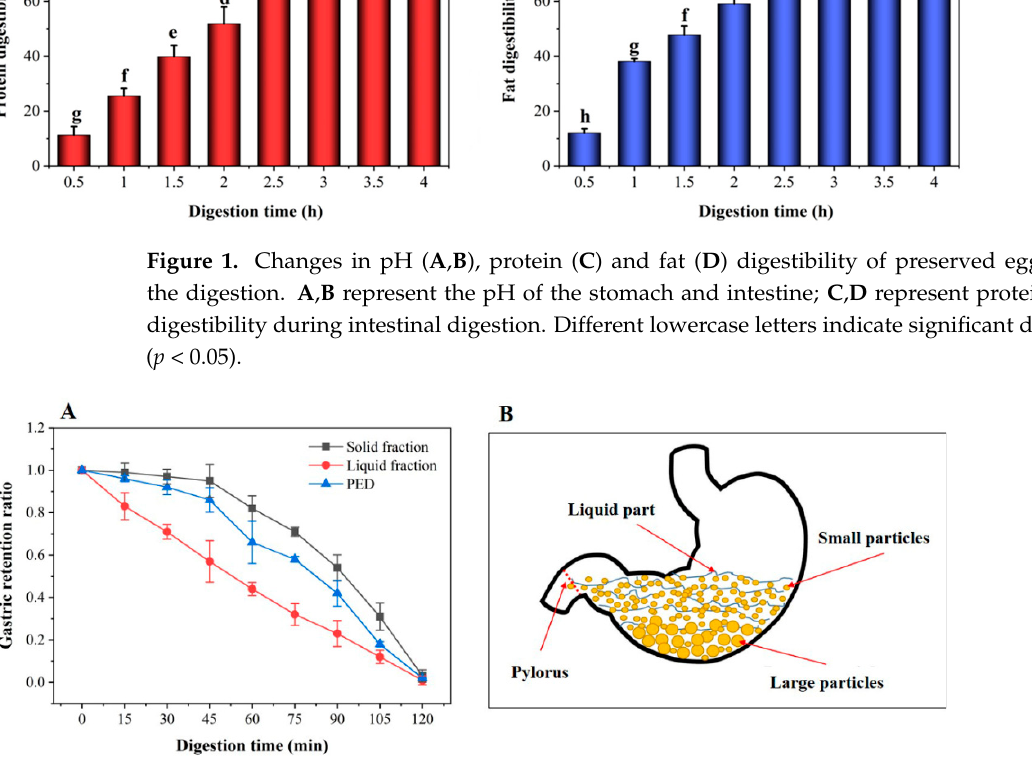
Figure 2. Gastric retention ratios ( A ) and the lagging phenomenon ( B ) of PED in the DHGI-IV model. PED: preserved egg digests; DHGI-IV: dynamic human gastrointestinal-IV.